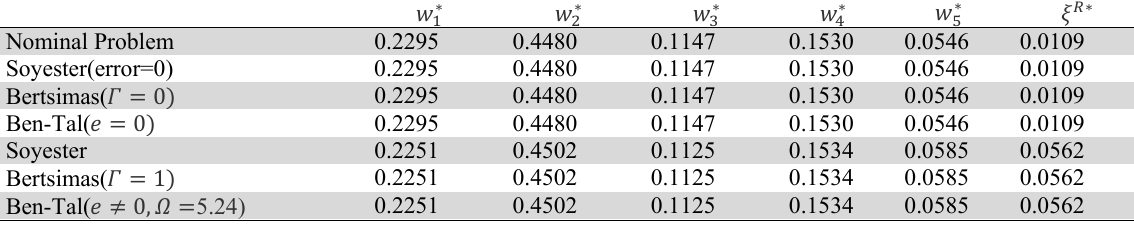
Numerical results of example